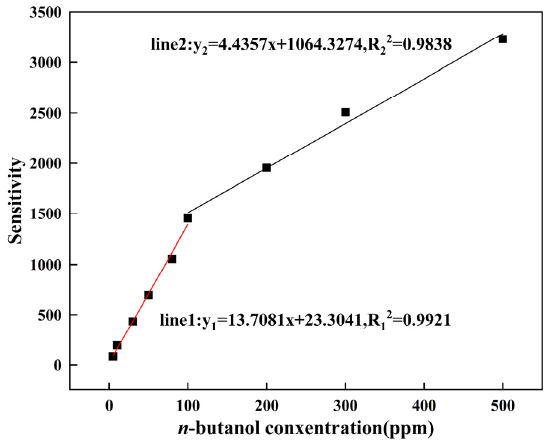
Figure 9. Linear relationship between material sensitivity and n -butanol concentration of Bi-ZnSnO 3 (4 wt%).